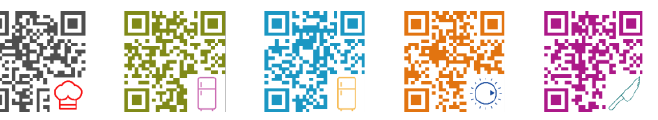
Figure 7. Custom-designed image targets for kitchen robot augmentation through a